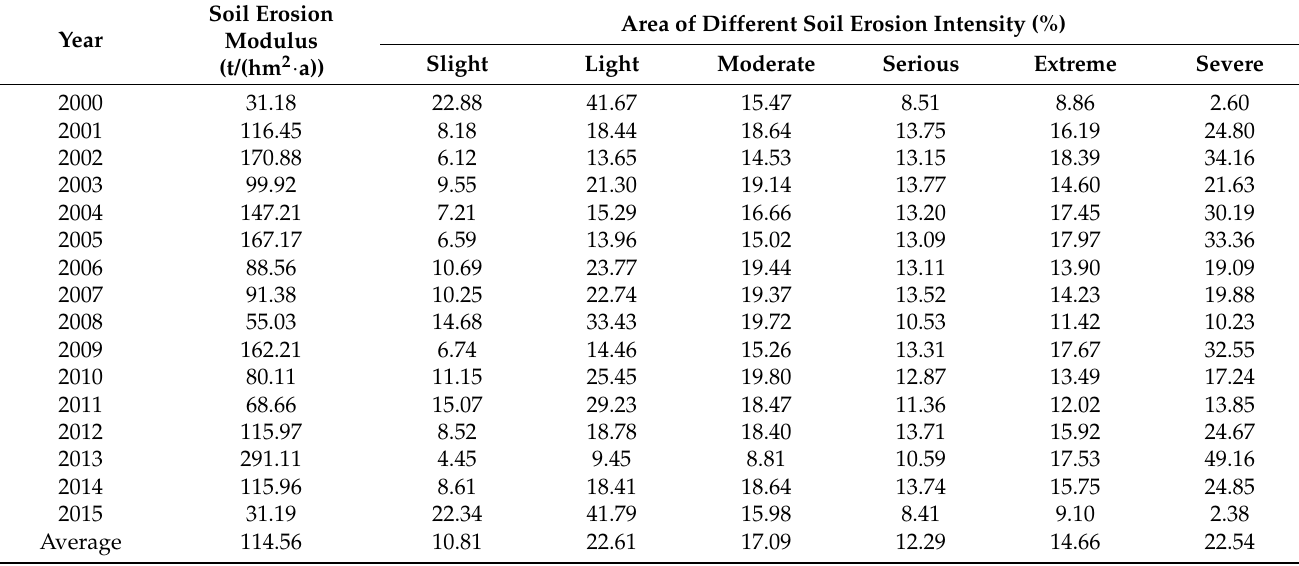
Table 4. Soil erosion in the Ansai Watershed from 2000 to 2015 under the initial scenario of vegetation restoration.